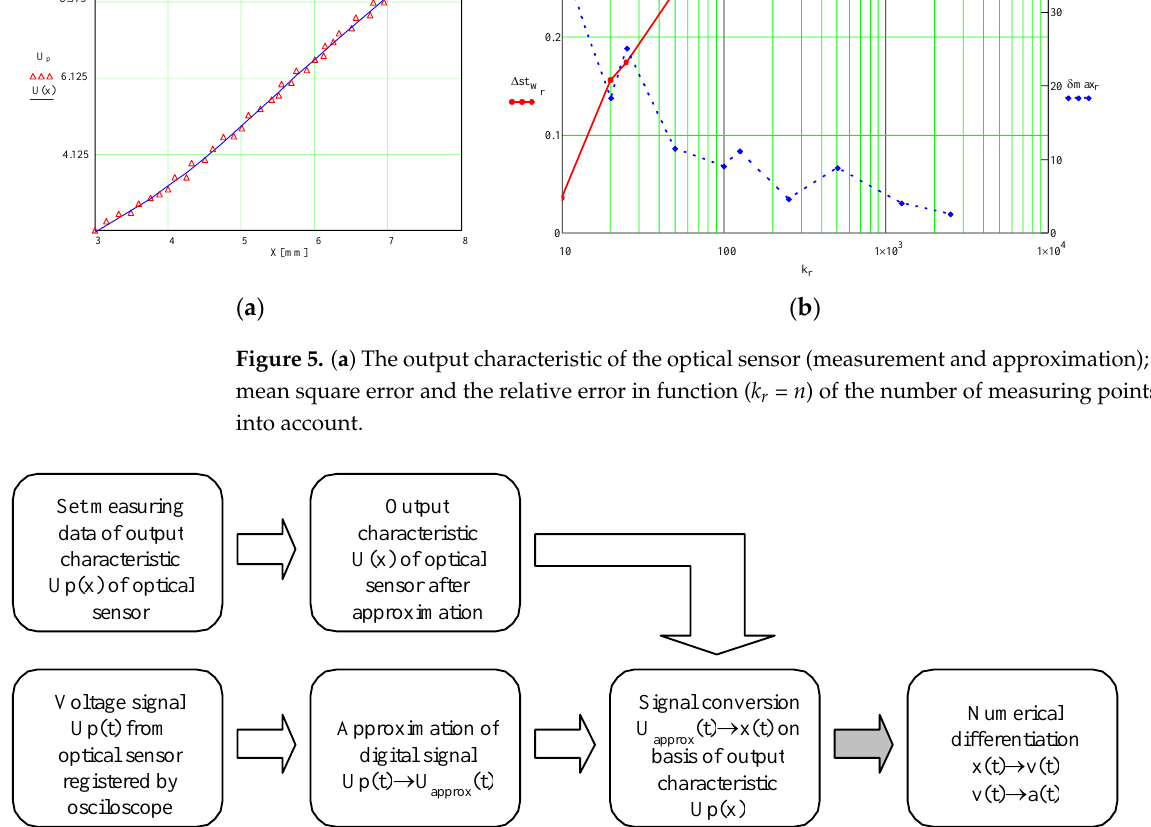
Figure 6. Block diagram of the procedure for determining the displacement waveform.